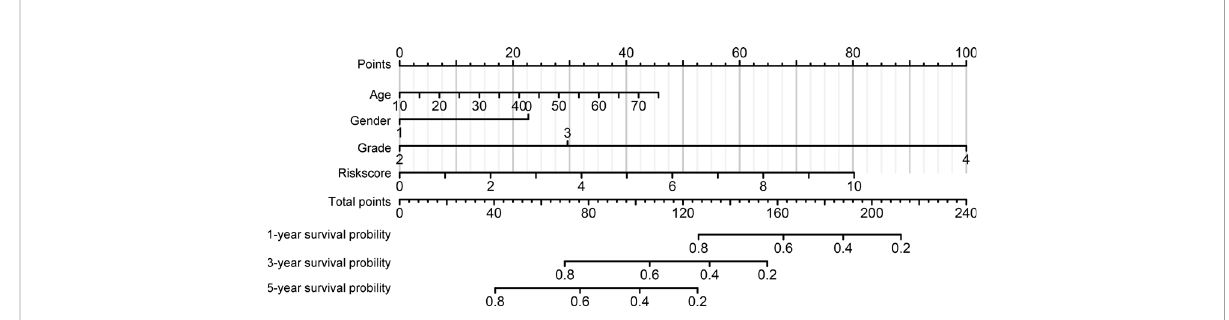
FIGURE 7 Construction of nomogram based on the signature risk score and clinical characteristics.